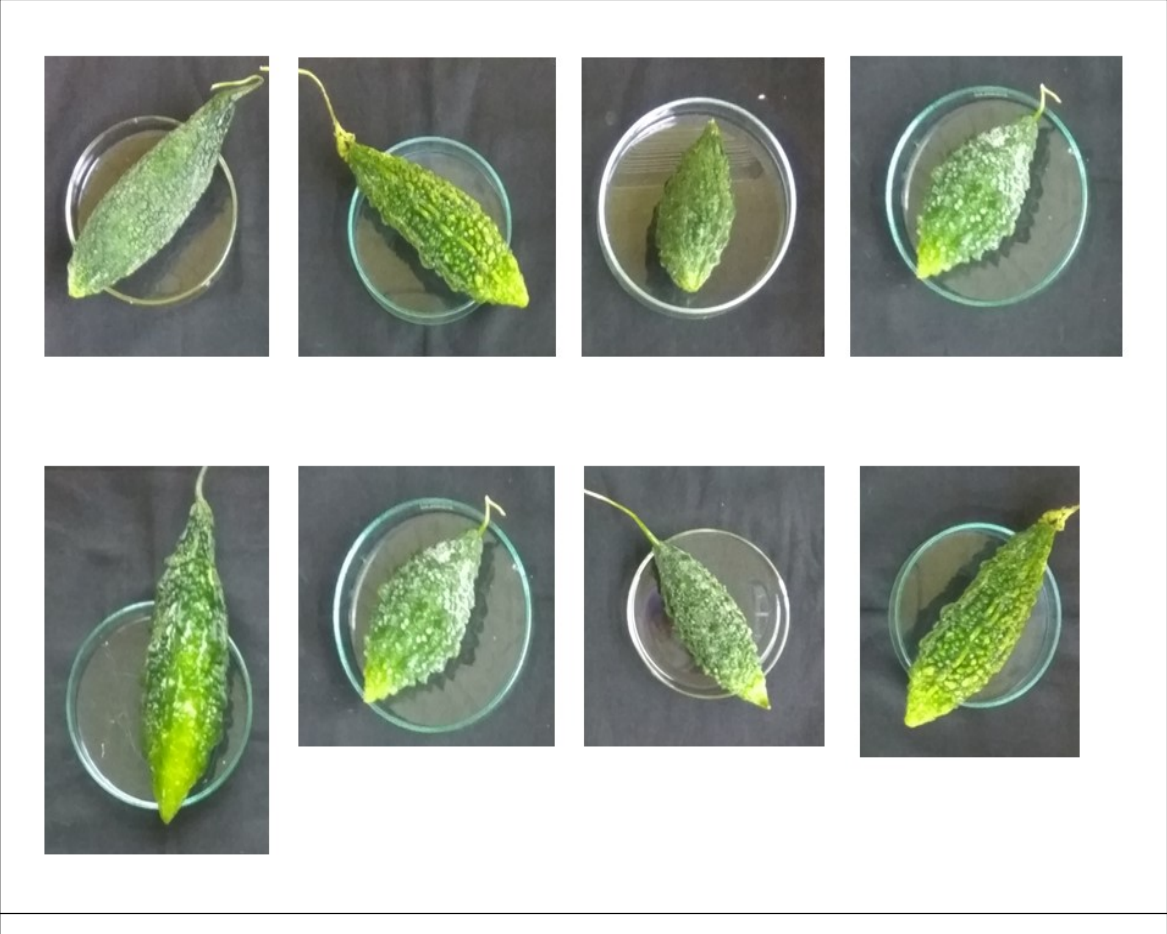
Figure 1: Fruits of different collection site a. Contai (Con); b. Tamluk (Tam); c. Basirhat (Bas); d. Bagnan (Bag); e. Behrampore (Beh), f. Duttapukur (Dut), g. Daspur (Das), h. Kharagpore